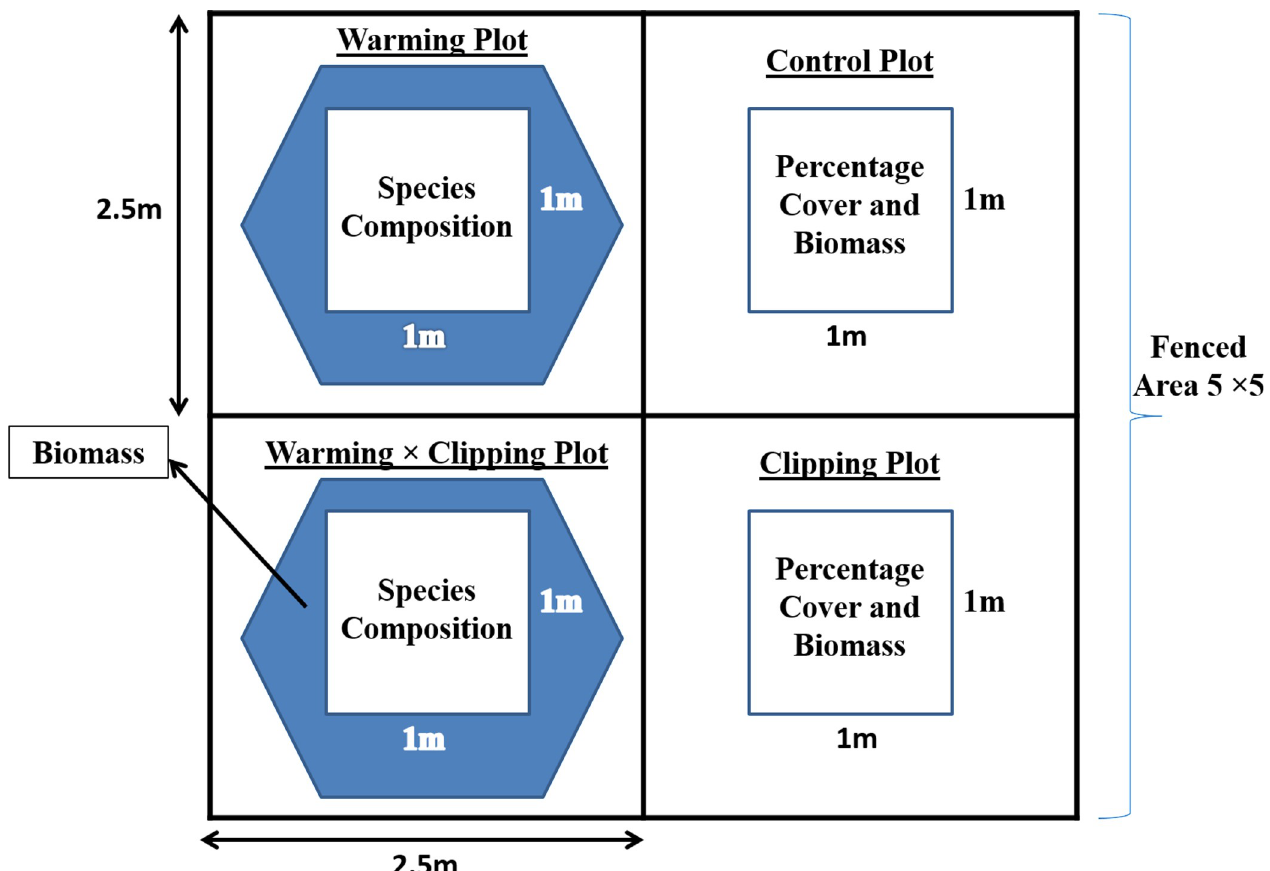
Fig 1. Schematic representation of a typical exclosure with open-top warming chambers (OTC) for passive heating, manual clipping plot for simulated grazing and control plots.